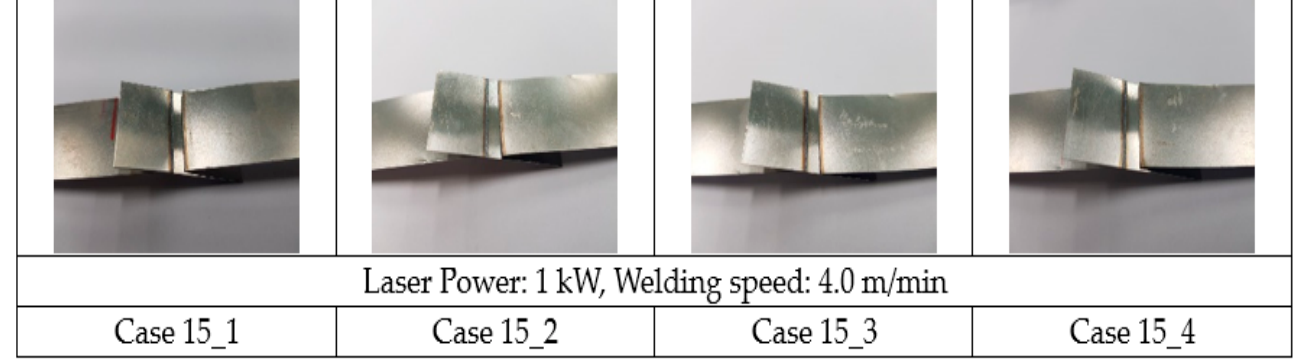
Figure 17. Case 15 condition appearance shape after shear fracture.